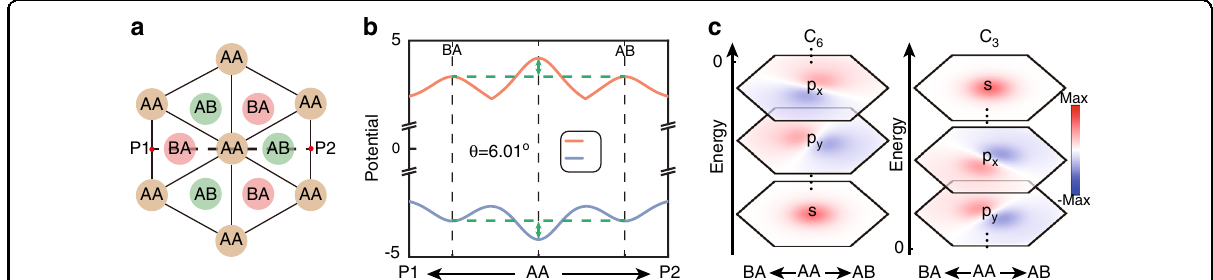
Fig. 4 Localized states obtained by the macroscopic effective energy potential well method. a Geometry arrangements of alternating AA and AB/BA stacked lattices and a typical dotted line P1P2 used for the analysis in ( b ). b Two potentials of V vary with the spatial parameter between P1 ffiffiffi p and P2 with θ = 6.01 ∘ and h ¼ a = 3 , which are obtained by the energies of S 1 and S 2 . Such a description is certainly valid for six different θ c . c Calculated eigenstates arranged from the lowest to highest energy. Panels are labeled as s and p x , y states for both E < 0 and E > 0 cases. Such fi led distributions reveal the corresponding C 6 and C 3 symmetries consistent with the exact eigenstates at Γ point of band structures of AA stacked lattices